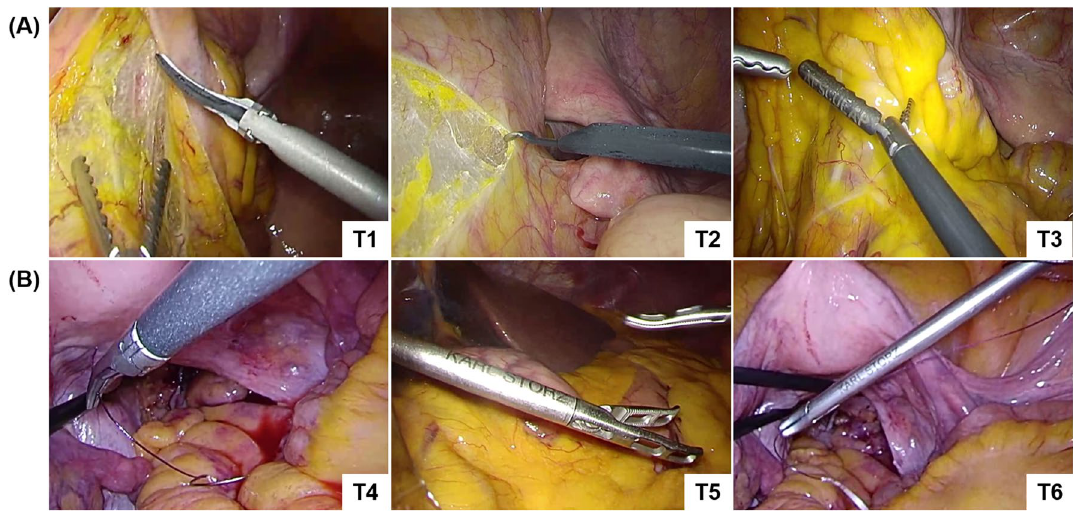
Figure 1. Representative images of recognition target surgical instruments in this study. ( A ) Surgical instruments contained in the training set (T1: harmonic shears; T2: endoscopic surgical electrocautery; T3: